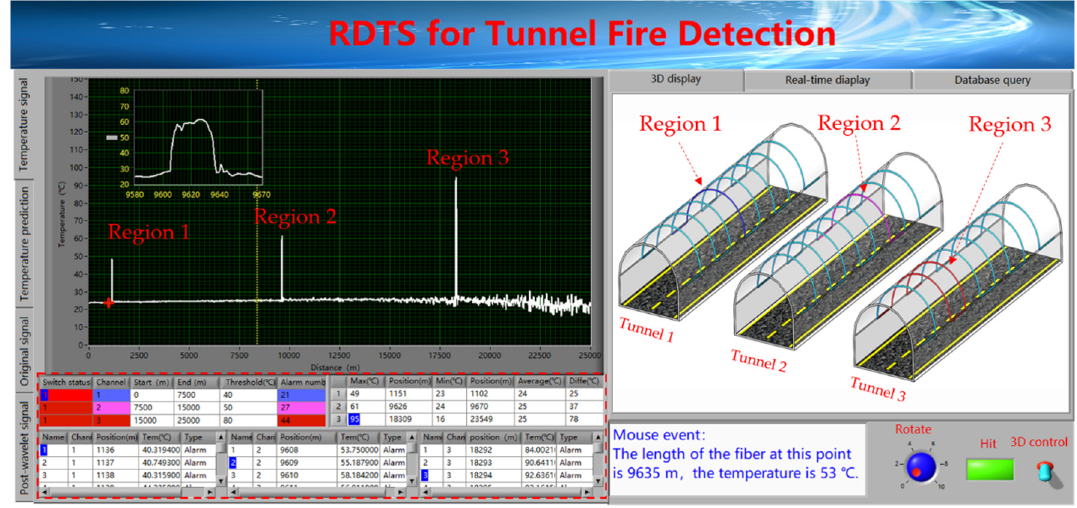
Figure 10. The platform of visual localization for tunnel groups.